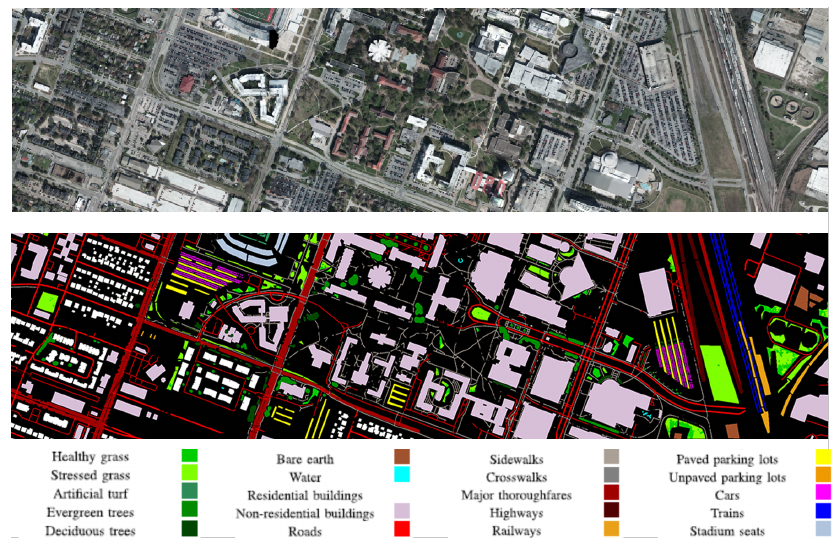
Figure 7. Exemplary RGB (top) and land cover annotation (bottom). Table 1. The original set of class and the corresponding